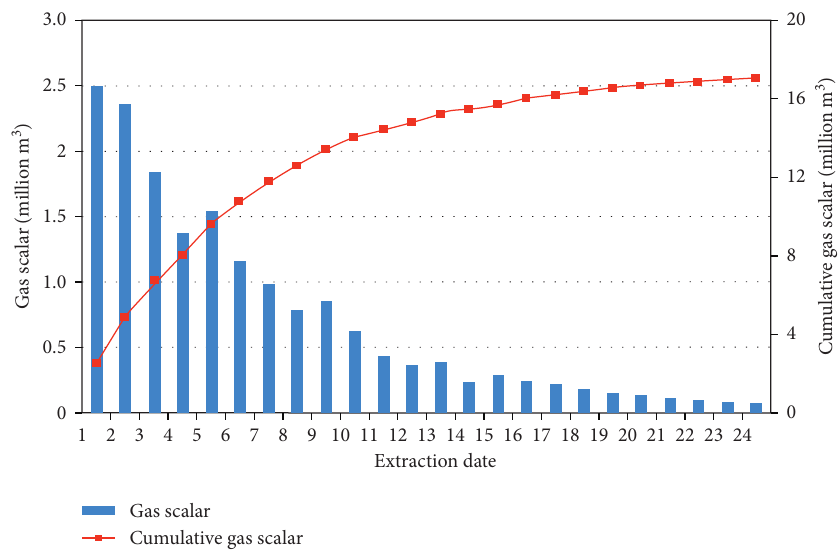
Figure 10: Gas extraction purity and cumulative extraction purity of borehole No. 1-1.